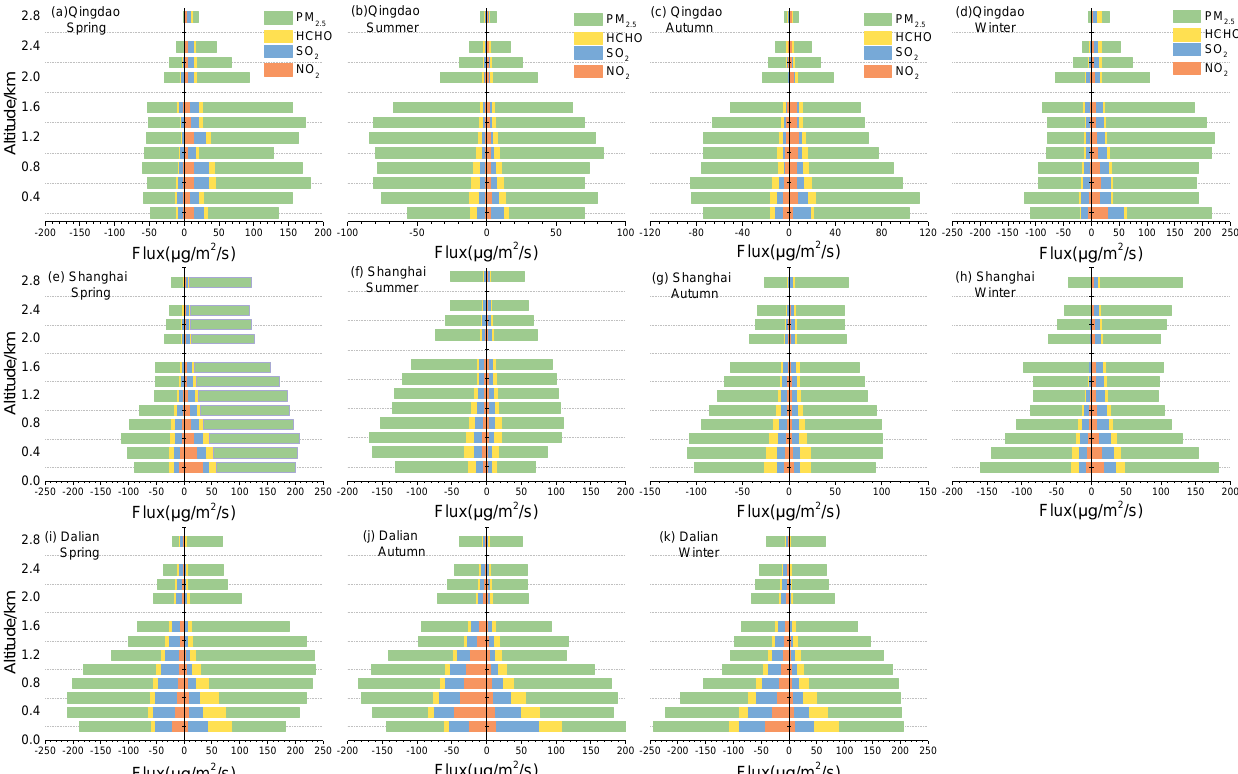
Figure 9. The input and output flux of particulate mass, NO 2 , SO 2 , and HCHO at Qingdao ( a–d ), Shanghai ( e–h ), and Dalian ( i–k ) in different seasons. The output flux of pollutant transport from inland to the sea was defined as positive, and the input flux of pollutant transport from the sea to inland was defined as negative.